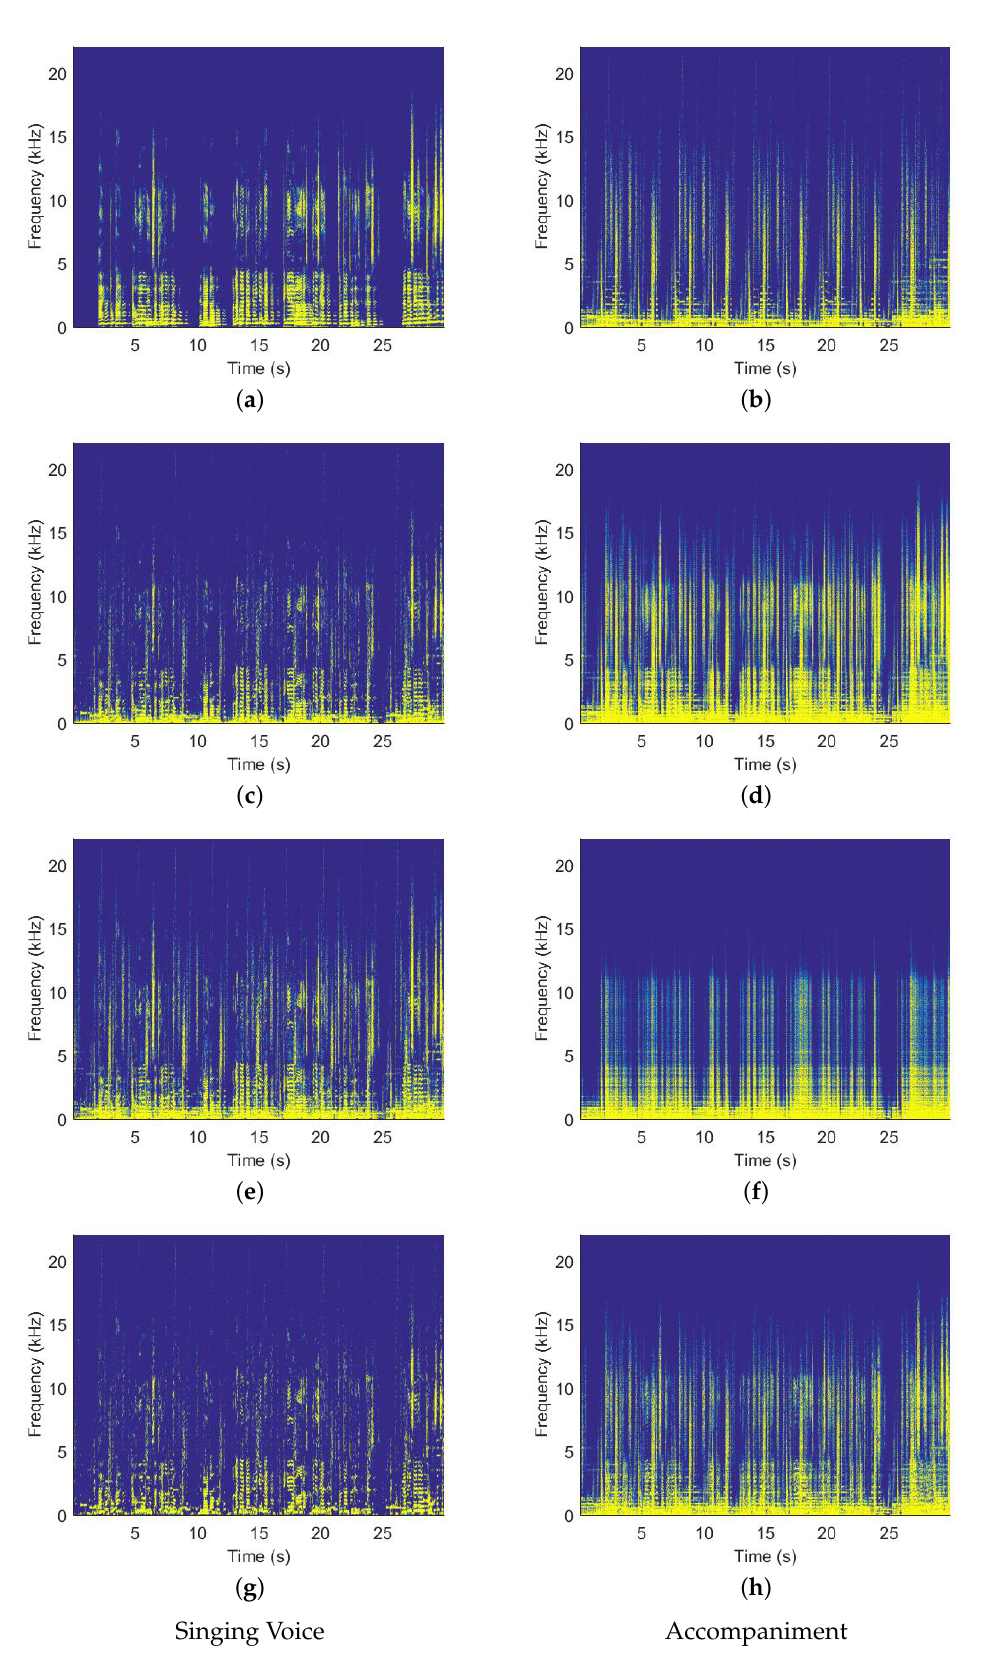
Figure 5. Examples are taken from the ccMixter dataset’s spectrograms. The singing voice is repre- sented by the left four spectrograms, whereas the equivalent musical accompaniment is represented by the right